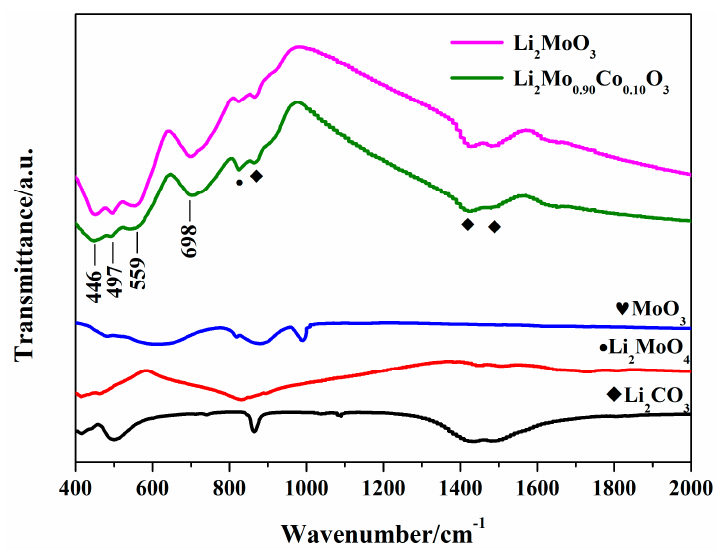
Figure 5. The FTIR spectra of Li 2 MoO 3 and Li 2 Mo 0.90 Co 0.10 O 3 .